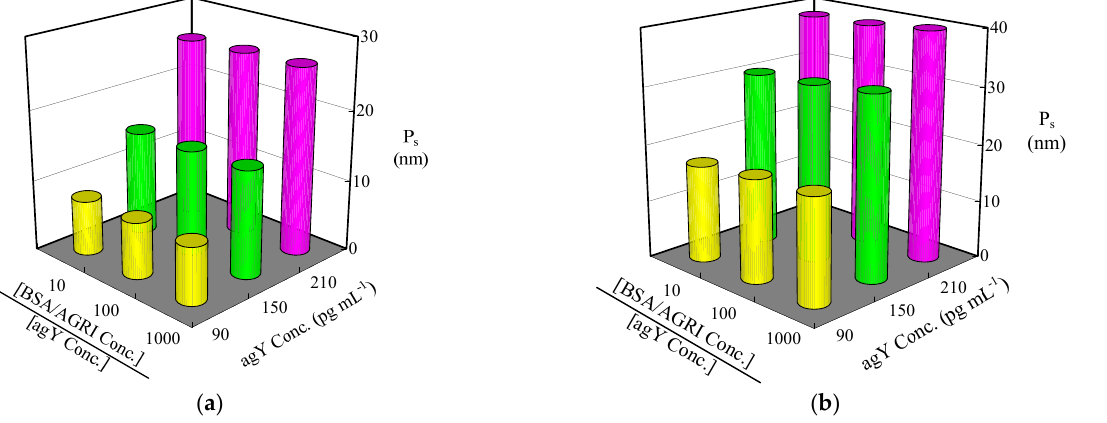
Figure 7. P s of peaks ( a ) IV and ( b ) V as a function of agY concentration at BSA and AGRI concentrations various times that of agY.